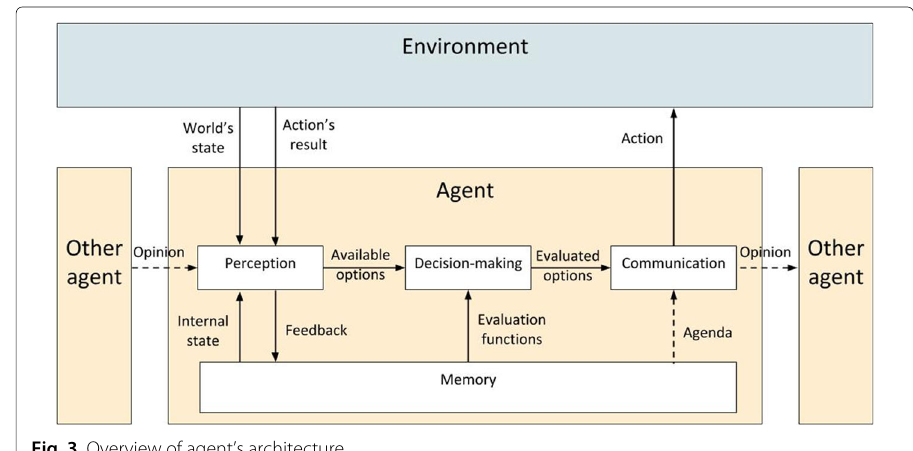
Fig. 3 Overview of agent’s architecture